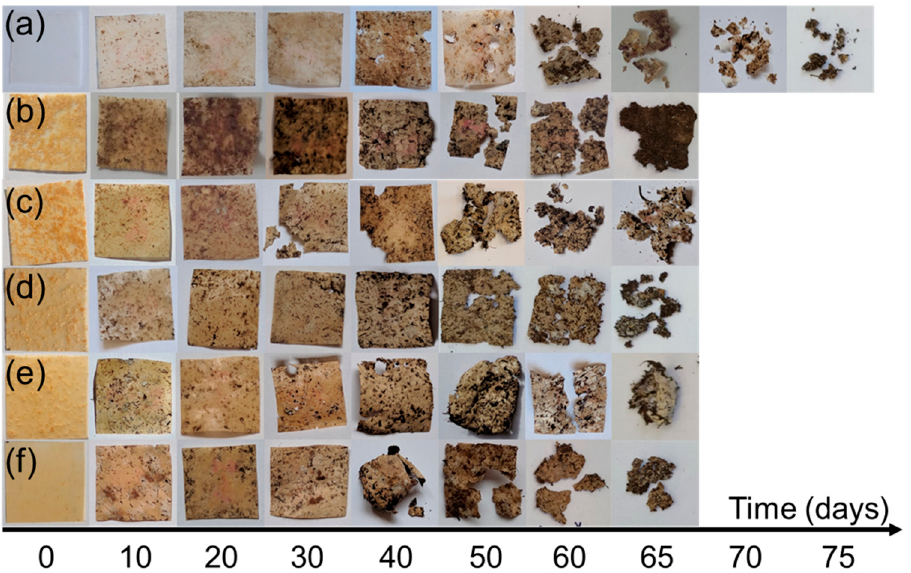
Figure 8. Photos of ( a ) PBS; ( b ) 40% NFC; ( c ) 7 / 3; ( d ) 5 / 5; ( e ) 3 / 7 and ( f ) 40% MCC films during